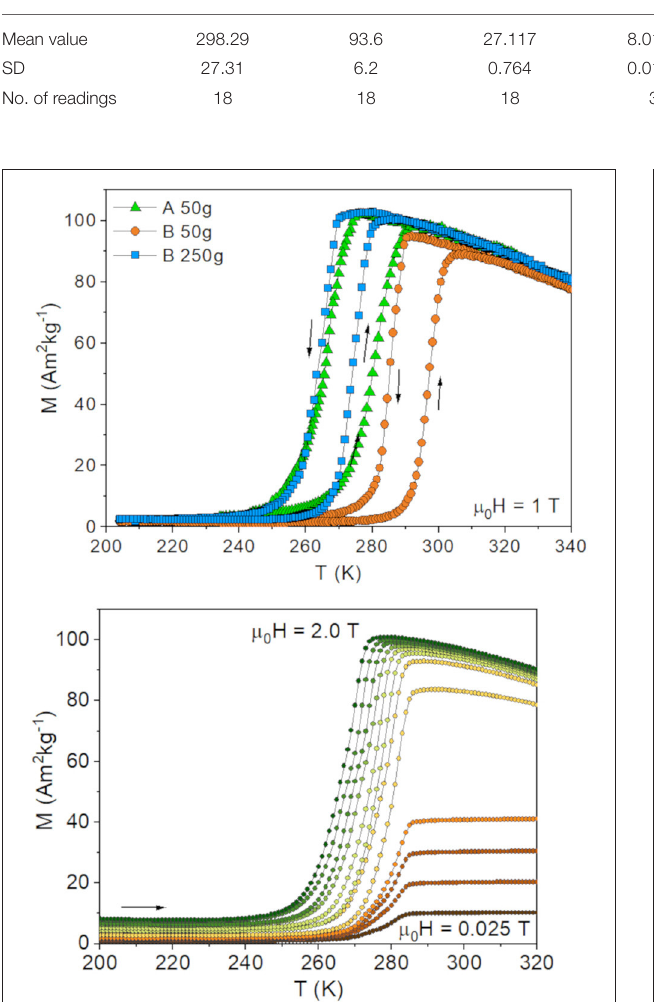
FIGURE 4 | Top panel : heating and cooling M ( T ) curves under a magnetic field of 1.0T for the A50 (triangles), B50 (circles), and B250 (squares) samples. Bottom panel : M ( T ) curves of B250 measured on heating under different applied magnetic fields between 0.025 and 2.0T.